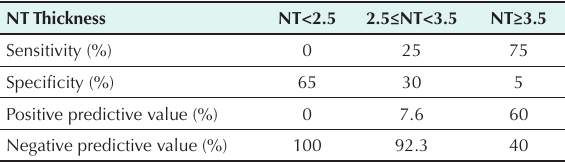
Table 4. The Sensitivity and Specificity of Relationship Between NT Thickness and Fetal Cardiac